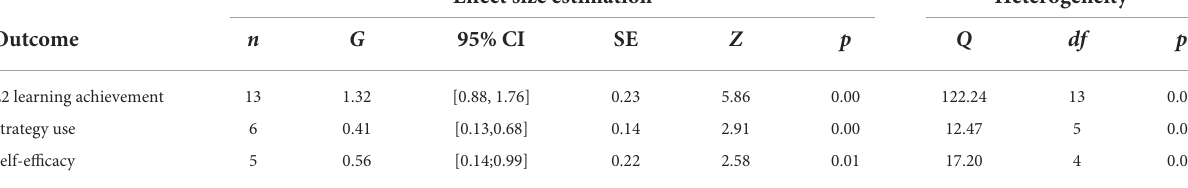
Effect size estimation